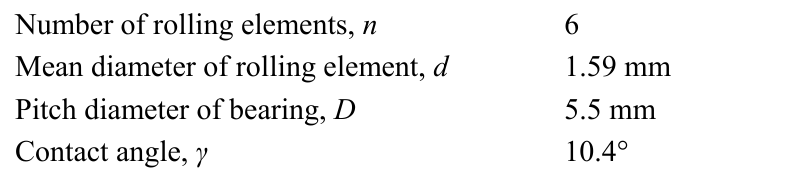
Table 1. The geometric specifications of the fan bearing in this